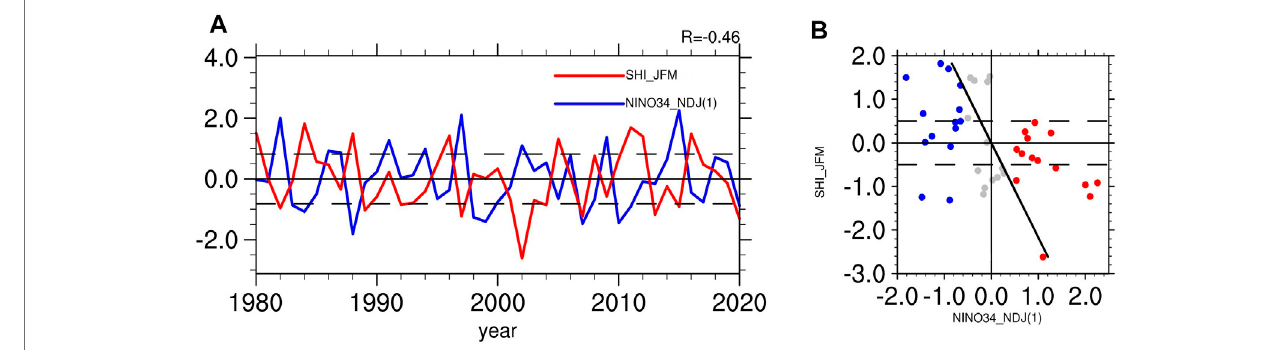
FIGURE 3 | (A) Time series of the JFM SHI index and NDJ (1) Niño-3.4 index during 1980 – 2020. The correlation coef fi cient shown in the upper right corner is the correlation with JFM SHI index leading NDJ (1) Niño-3.4 index. (B) Scatter plots of the JFM SHI and NDJ (1) Niño-3.4 indices. Both indices are normalized by their standard deviations (STDs), and the red (blue) points are the years with Niño-3.4 indices greater than 0.5 STDs (less than − 0.5 STDs), indicating strong El Niño (La Niña) events; grey spots are neutral events. The lines represent the regression fi t. Dashed lines indicate that JFM SHI index is equal to 0.5